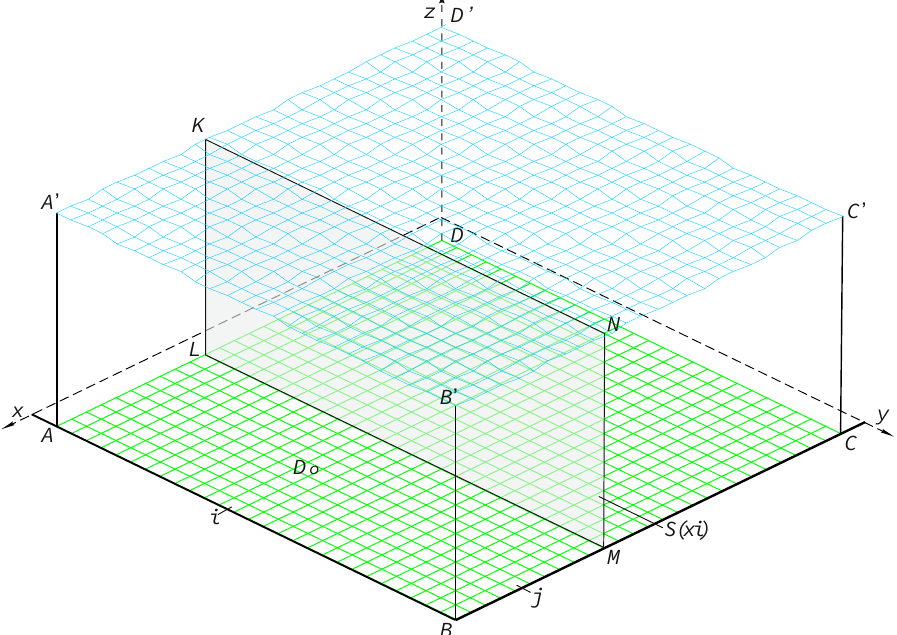
Figure 7. Scheme for computer-based volume determination.